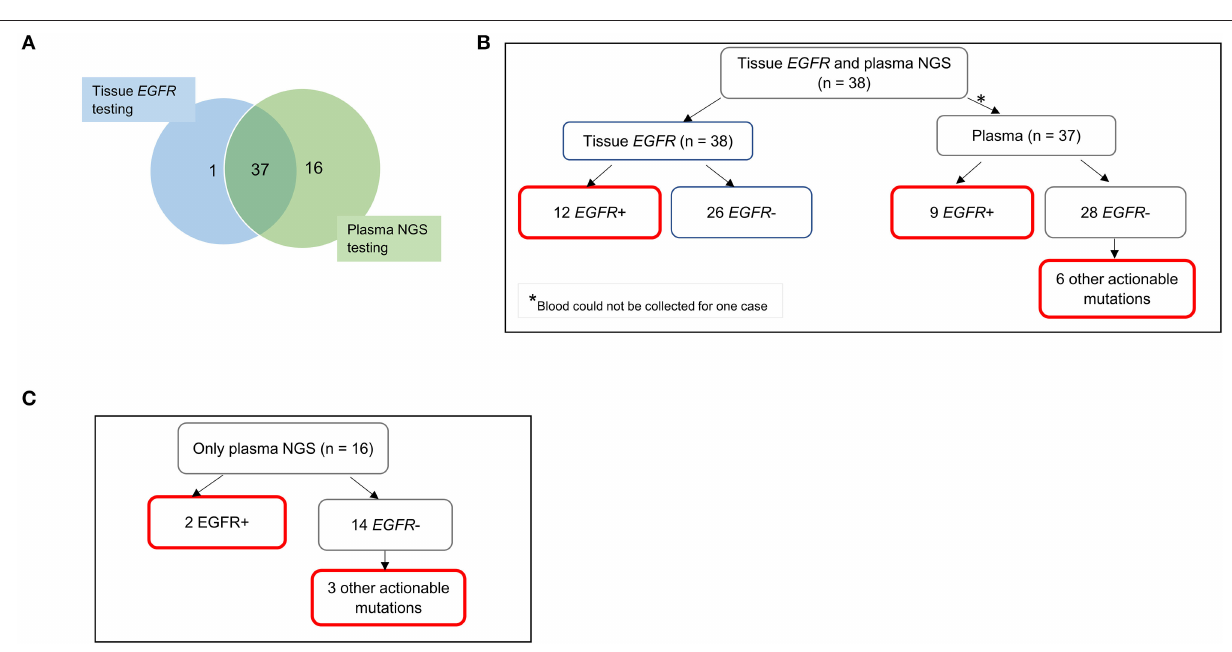
Frontiers in Medicine |